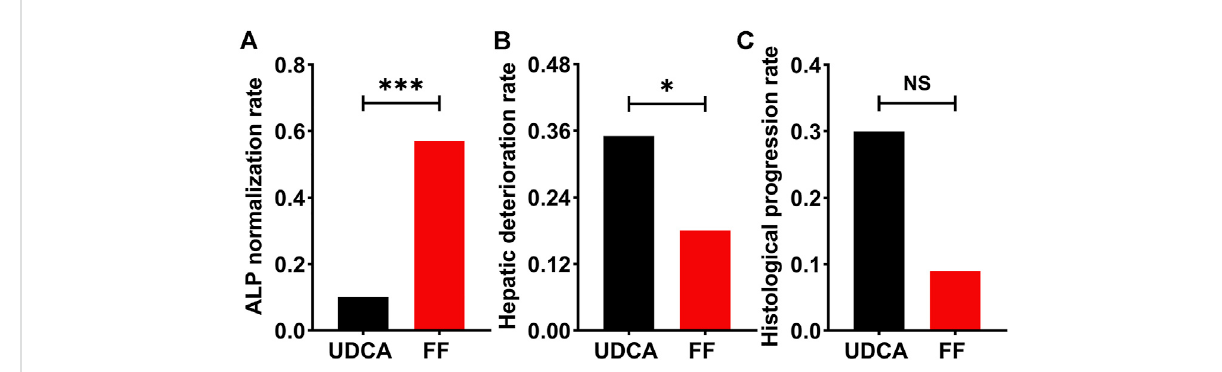
FIGURE 8 The incidence of primary and secondary outcomes in UDCA-refractory PBC patients treated with UDCA + FF (the FF group) or UDCA monotherapy (theUDCAgroup). (A) ALPnormalizationrate (B) Hepaticdeteriorationrate (C) Histological progressionrate.Datawasanalyzed bythe